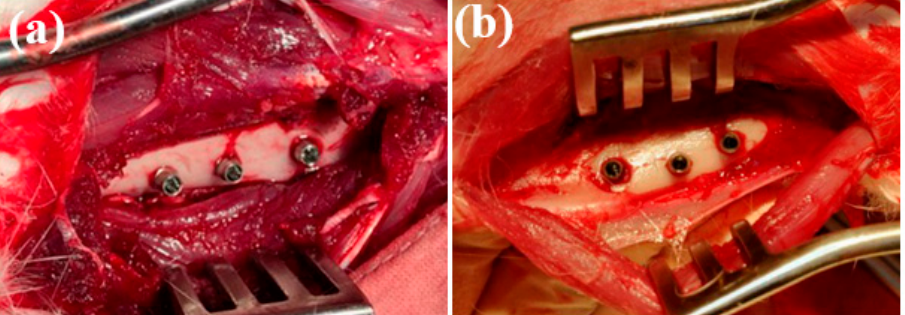
Figure 6. ( a ) Ti64/SA implants after 8 weeks of implantation, and ( b ) Ti64/7 ion implants after 8 weeks of implantation. As shown in ( a , b ), the implant fixture is well connected with the surrounding bone.